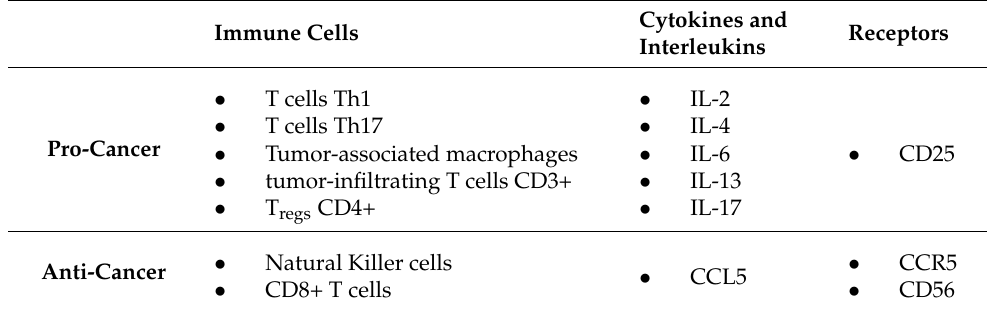
Table 1. Summary of cell types, cytokines, and interleukins involved in the prostate microenviron- ment during PCI and their link with